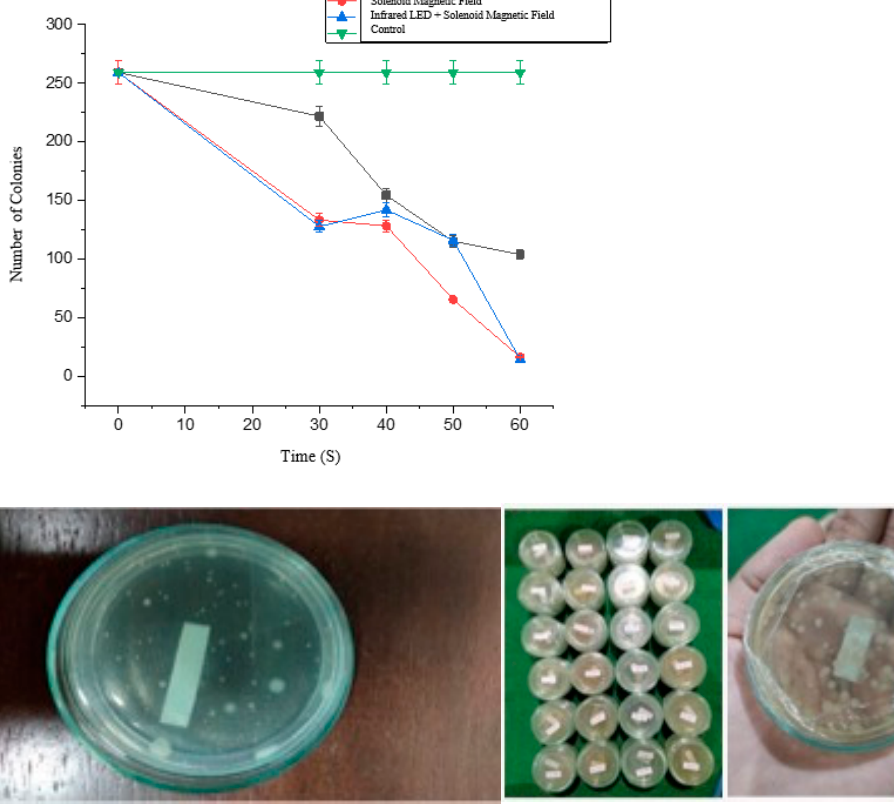
Figure 11. Graph of the decrease in the number of S. aureus colonies with time from treatment results with the original agar plate containing the number of colonies .